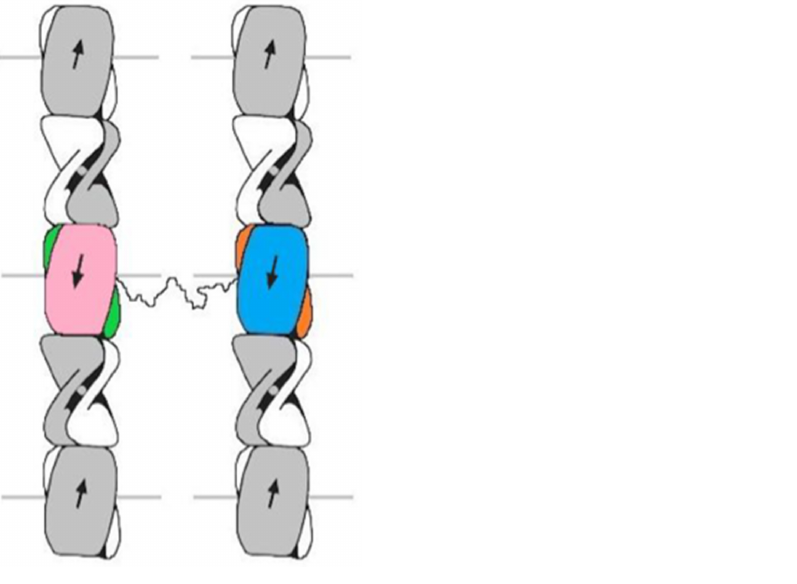
Figure 7. The structure proposed for the chains with four 34-residue repeats contains two ß-sandwiches (pink/green and blue/orange). One occurs in each of two neighboring filaments and are linked by the sequence connecting repeats 2 and 3 (represented by a wavy line). The linker is believed to adopt a ß-like sheet characterized by stretches of sequence with a serine-X repeat. Figure reproduced from [67] with permission of